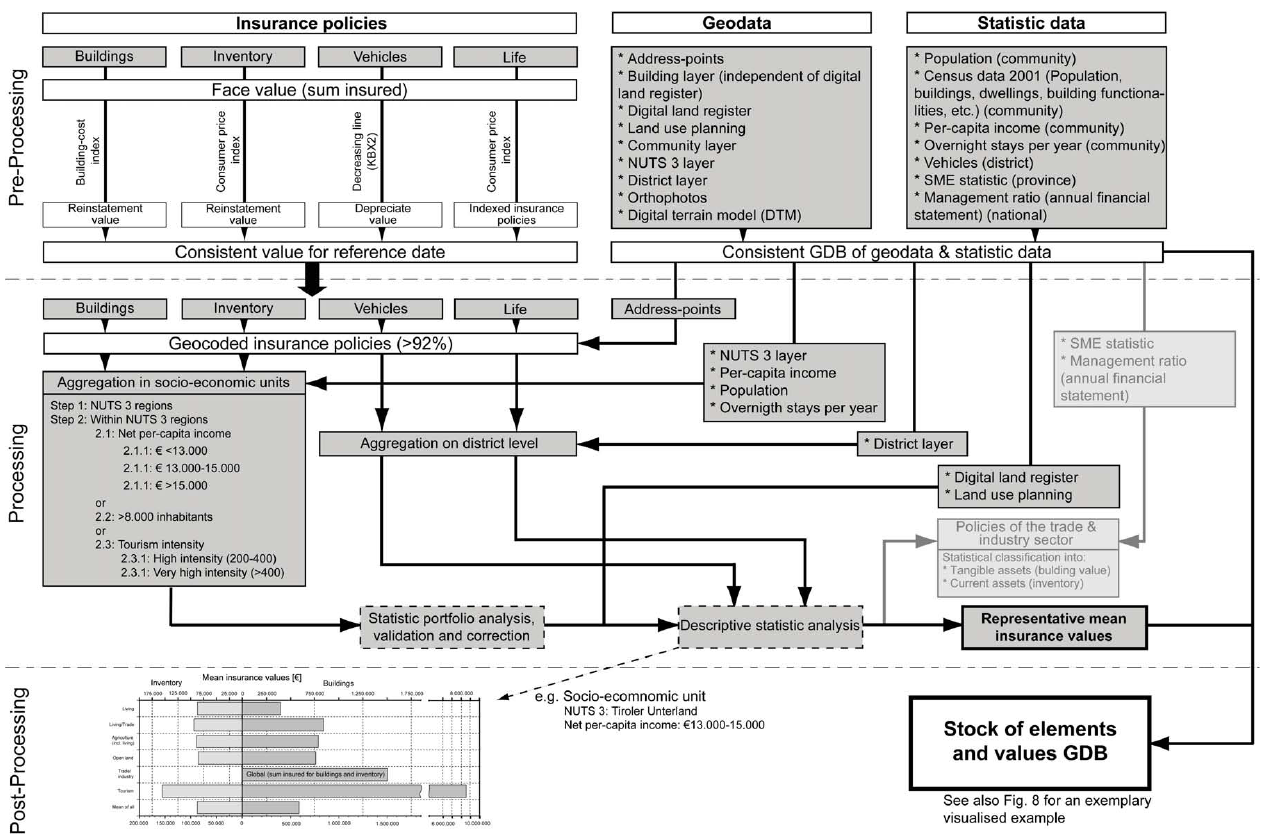
Fig. 4. Methodology, working steps, and combination towards a consistent geodatabase (GDB) of the stock of elements and values (the listed example of a socio-economic unit should only adumbrate the level of detail, for more details see Huttenlau and St¨otter,